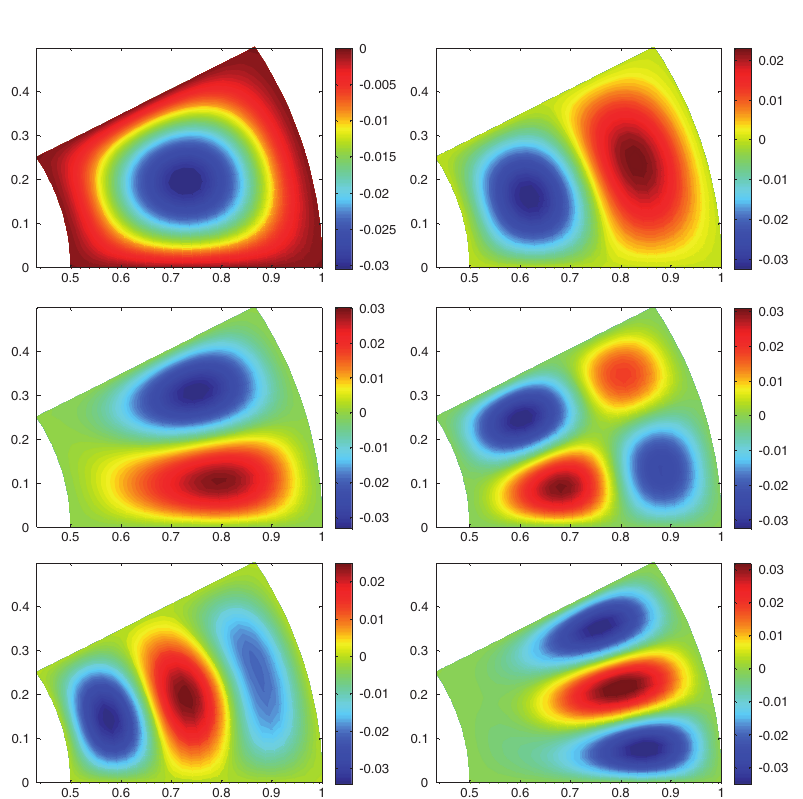
Figure 12 The first six mode shapes of a fully clamped orthotropic FGM annular sector plate for n = 0.1 and θ = 30 ° .